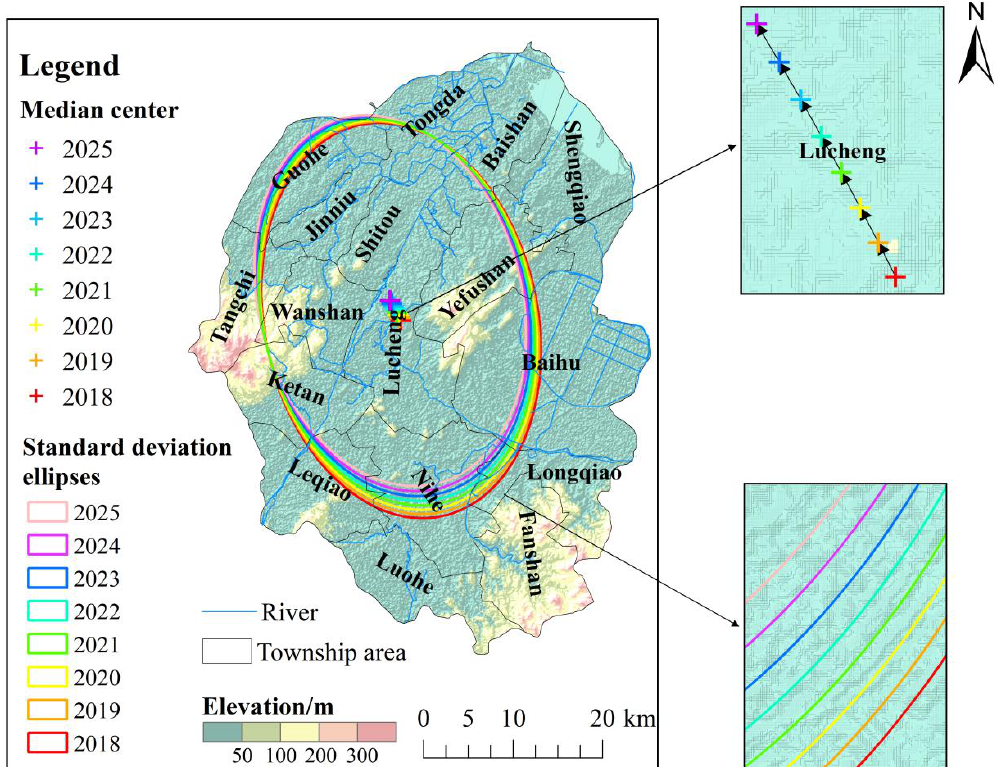
Figure 8. The standard deviational ellipse and gravity center transfer path of the incidence of digestive tract cancer in residents of Lujiang County from 2018 to 2025.